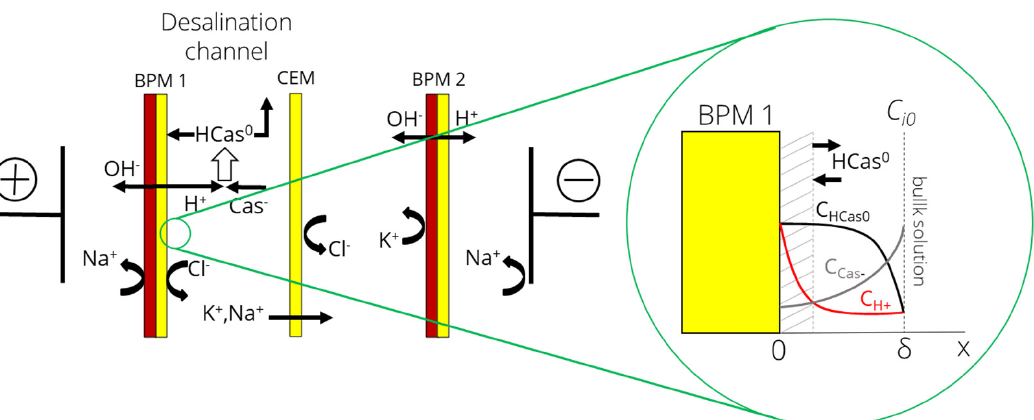
Figure 2. Schematic representation of the simulated system, including the BPM cationic interface (x = 0) and DBL (x = δ ) of the desalination channel. Here Cas - and HCas 0 are anions and molecules of (x = 0) and DBL (x = δ ) of the desalination channel. Here Cas − and HCas 0 are anions and molecules casein, respectively. of casein,